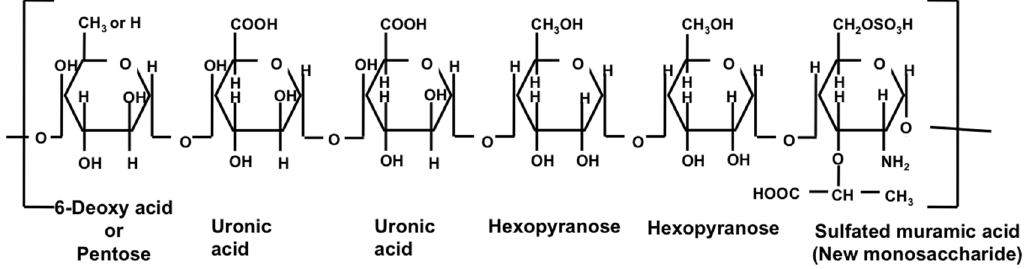
Figure 3. Structure of sacran [46].